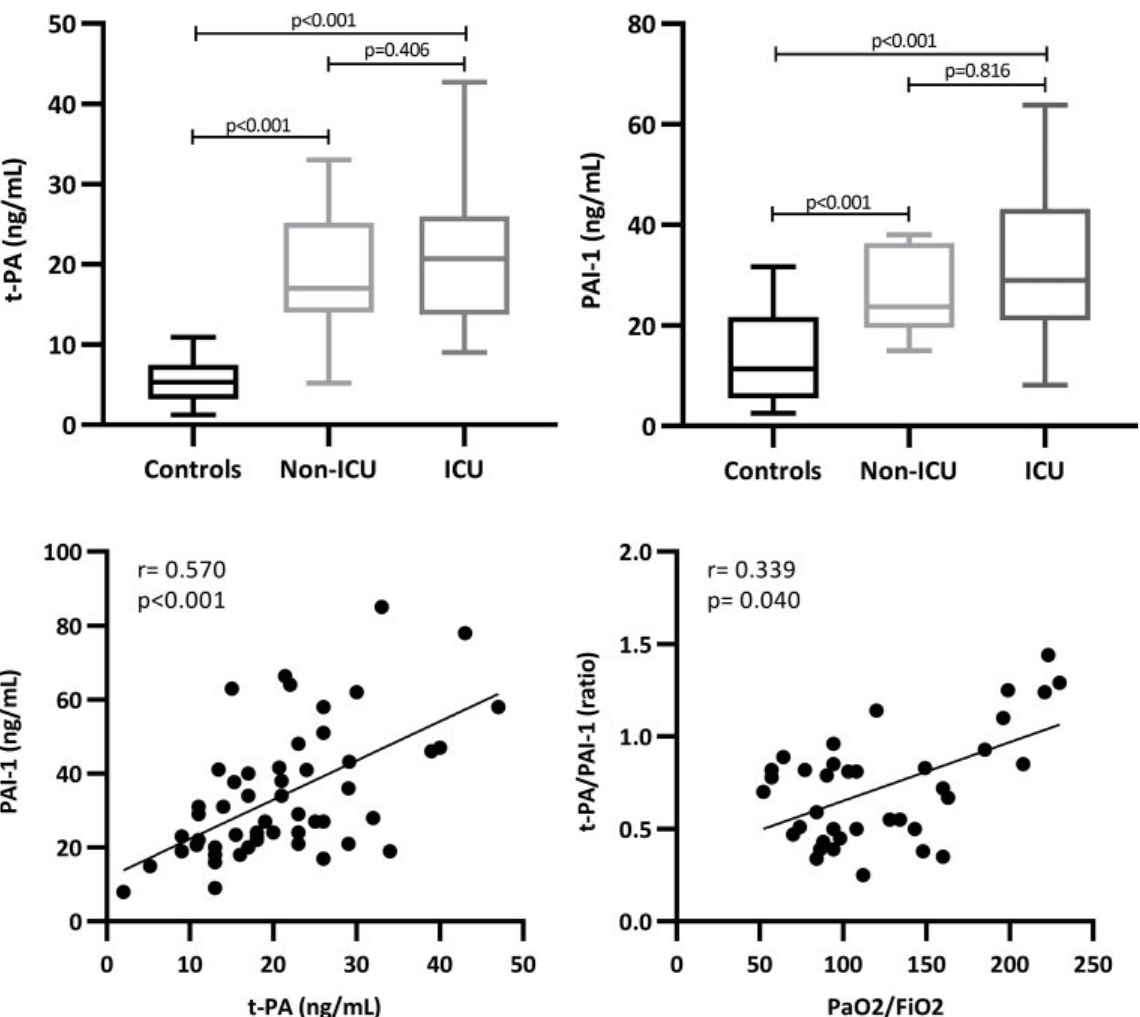
Fig. 3 Fibrinolytic proteins levels (t-PA and PAI-1) in non-ICU and ICU patients compared with controls and their relationship with PaO2/FiO2 index.